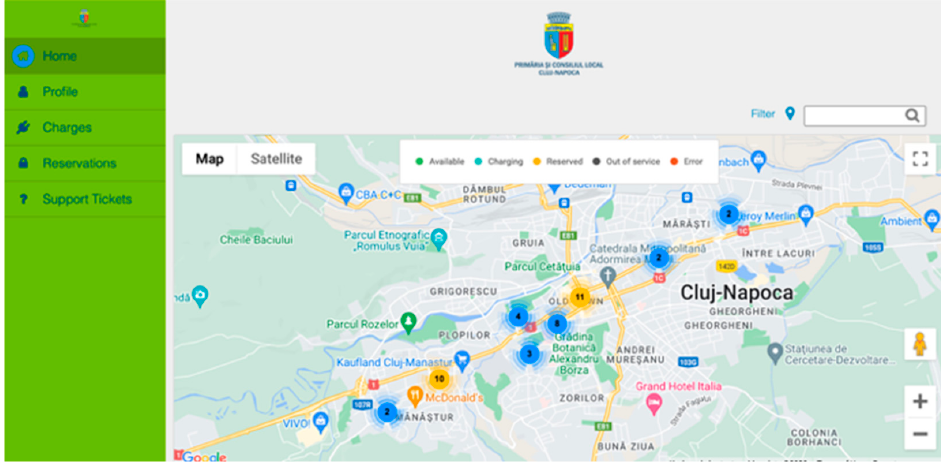
Figure 7. Distribution of EV charging stations in Cluj-Napoca in June 2022.